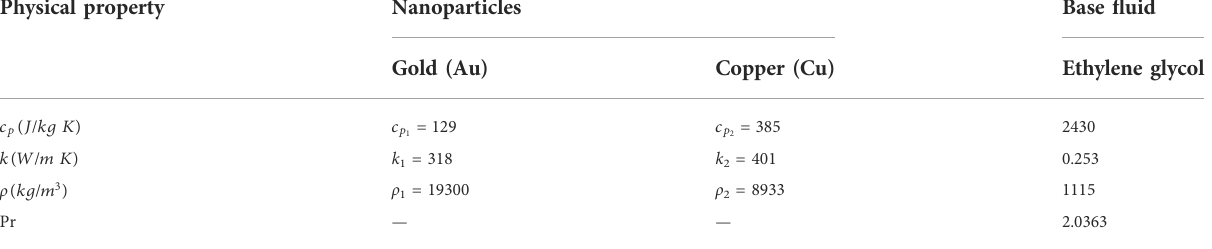
TABLE 1 Thermo-physical properties of the base fl uid and nanoparticles [ 33 , 45 ] . Physical property